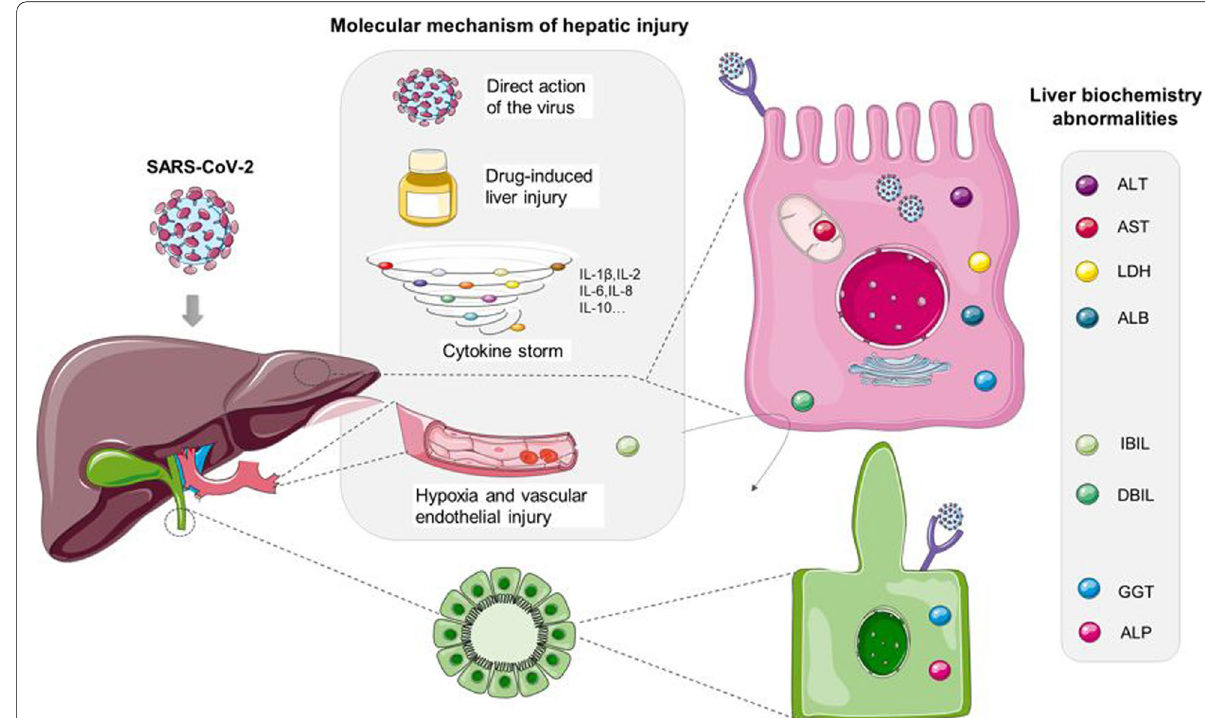
Fig. 1 Cited in the Mediterranean Journal of Hematology and Infectious Diseases , Mechanism of SARS-CoV-2 Invasion into the Liver and Hepatic Injury in Patients with COVID-19 published on January 1,